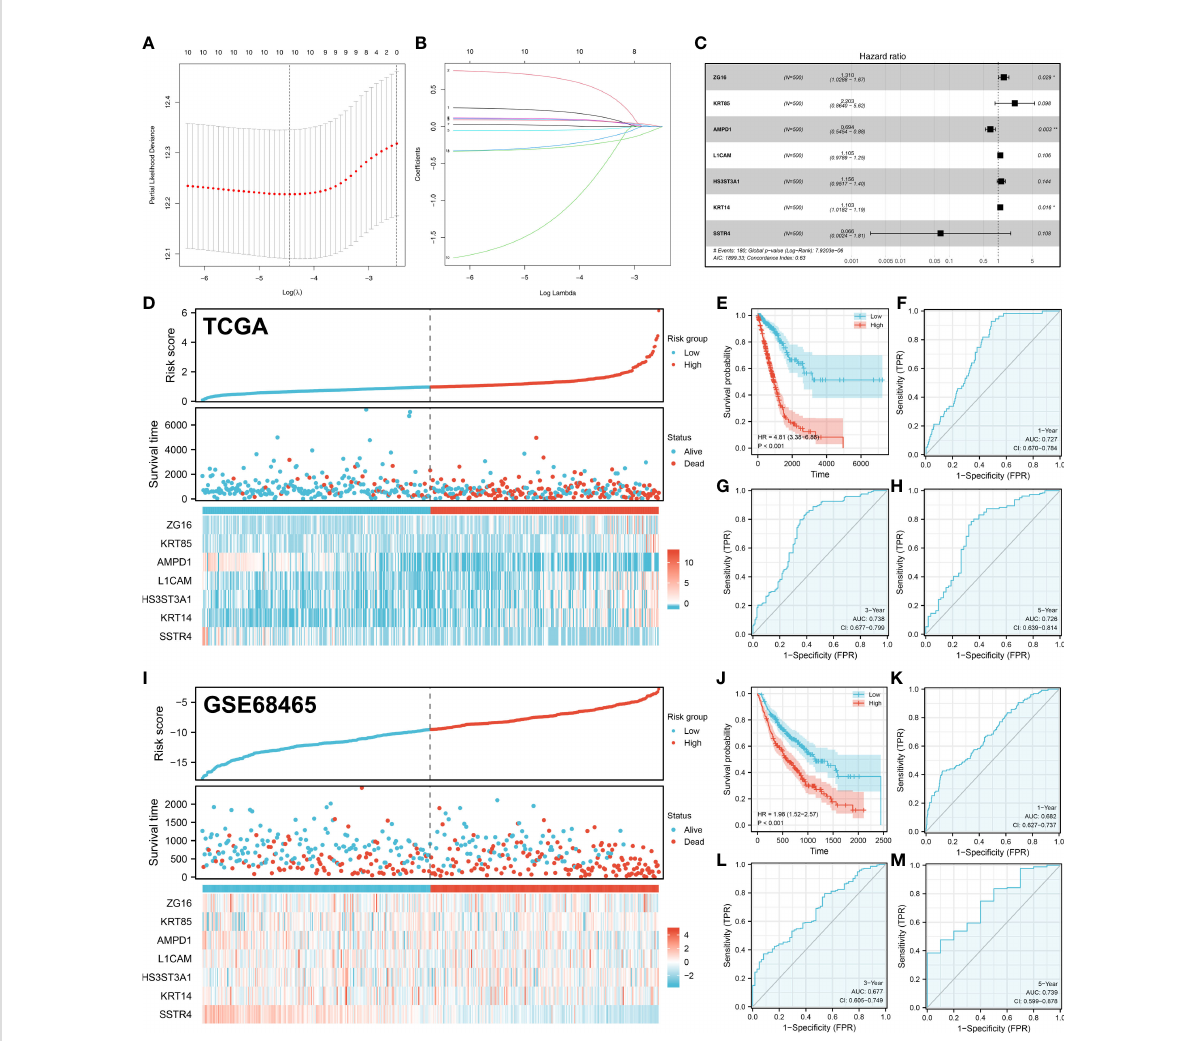
FIGURE 4 Prognosis model construction. (A-B) The lasso regression analysis was used for data dimension reduction; (C) A prognosis signature consisting of characteristic molecules was constructed by multivariate cox regression analysis; (D) LUAD patients involved in TCGA cohort was divided into low-risk and high-risk groups based on the median cut-off; (E) The Kaplan-Meier curve was used to demonstrate the OS between low-risk and high-risk groups in TCGA cohort; (F) The time-dependent ROC curves reveals the 1-year predictive value of prognostic in TCGA cohort; (G) The time-dependent ROC curves reveals the 3-year predictive value of prognostic in TCGA cohort; (H) The time-dependent ROC curves reveals the 5-year predictive value of prognostic in TCGA cohort; (I) LUAD patients involved in GEO cohort was divided into low-risk and high-risk groups based on the median cut-off; (J) The Kaplan-Meier curve was used to demonstrate the OS between low-risk and high-risk groups in GEO cohort; (K) The time-dependent ROC curves reveals the 1-year predictive value of prognostic in GEO cohort; (L) The time-dependent ROC curves reveals the 3-year predictive value of prognostic in GEO cohort; (M) The time-dependent ROC curves reveals the 5-year predictive value of prognostic in GEO cohort;. *P < 0.05, **P <